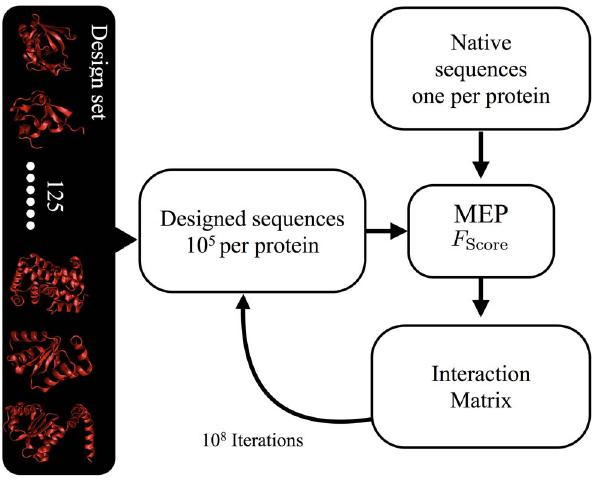
Figure 2. Schematic representation of the MEP algorithm. For a trial set of the E , E HOH , and V parameters and for each protein in the training set a large number (10 5 ) of sequences with composition fixed to the natural one are generated following the design scheme in the SM. The scoring function F score (Eq.S16 in the SM) is then evaluated and the trial parameters are accepted or reject according to a Metropolis like scheme. New parameter sets are generated at each iteration, and the sequences of the proteins in the training set are re- designed by 10 5 simple pair residue swapping moves, which are accepted or rejected according to a standard Metropolis algorithm with the energy defined in Eq.S4 (see SM). During each design iteration, the HP and energy profiles (Eq.S16 in the SM) are averaged over the observed sequences weighted by their Boltzmann weight. The averaging guarantees that the profiles are calculated over the most probable sequences that, as we showed previously [43], are robust against mutations and are more thermally stable. After , 10 8 iterations the interaction parameters converged to their final values: V ~ 21 : 0 + 0 : 5 and E HOH ~ 0 : 015 + 0 : 001 , and the residue-residue E interaction parameters which are listed in Tab. S1 of the SM.